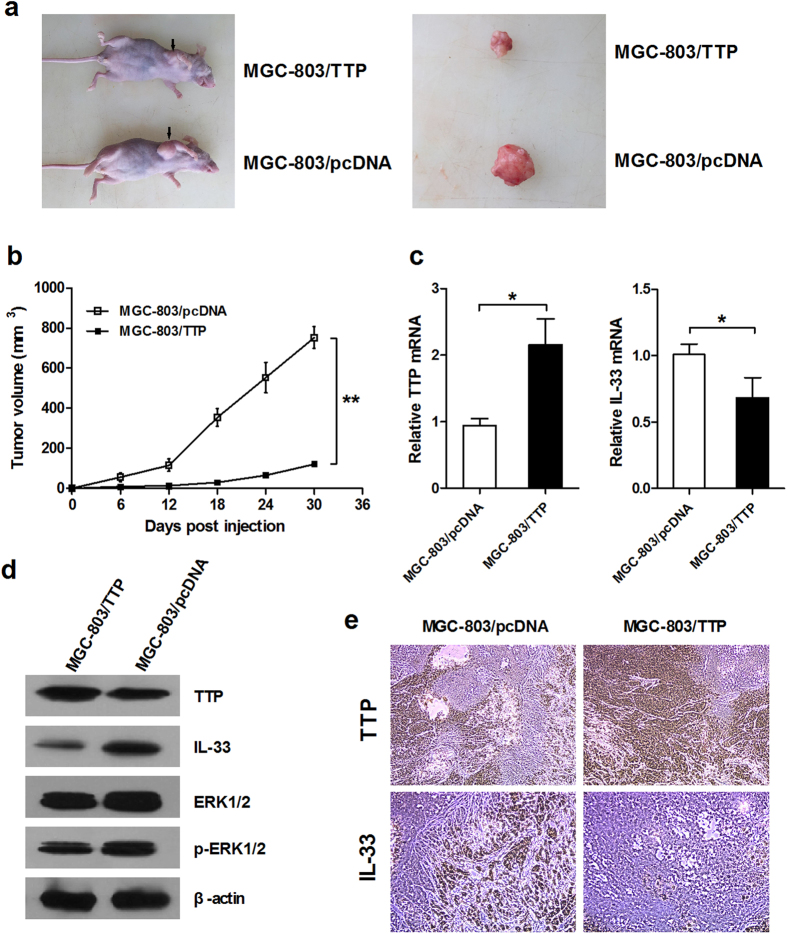
Overexpression of TTP suppresses tumor growth of GC in vivo.(a) Representative photographs of nude mice (top) and resected tumors (bottom) taken 30 days after injection with MGC-803/TTP or MGC-803/pcDNA cells. (b) Volumes of subcutaneous tumors generated by MGC-803/pcDNA or MGC-803/TTP cells. The tumors were measured every 6 days and surgically removed after 30 days of growth. (c) qRT-PCR analysis for the expression of TTP and IL-33 in MGC-803/pcDNA and MGC-803/TTP tumor tissues. (d) Expressions of TTP, IL-33, ERK1/2 and phosphorylation of ERK1/2 (p-ERK1/2) were examined by Western blotting in subcutaneous tumors of nude mice. (e) Immunohistochemical staining (200× magnification) for the expression of TTP and IL-33 in subcutaneous tumors. The data are represented as the mean ± SD. *P < 0.05, **P < 0.01.